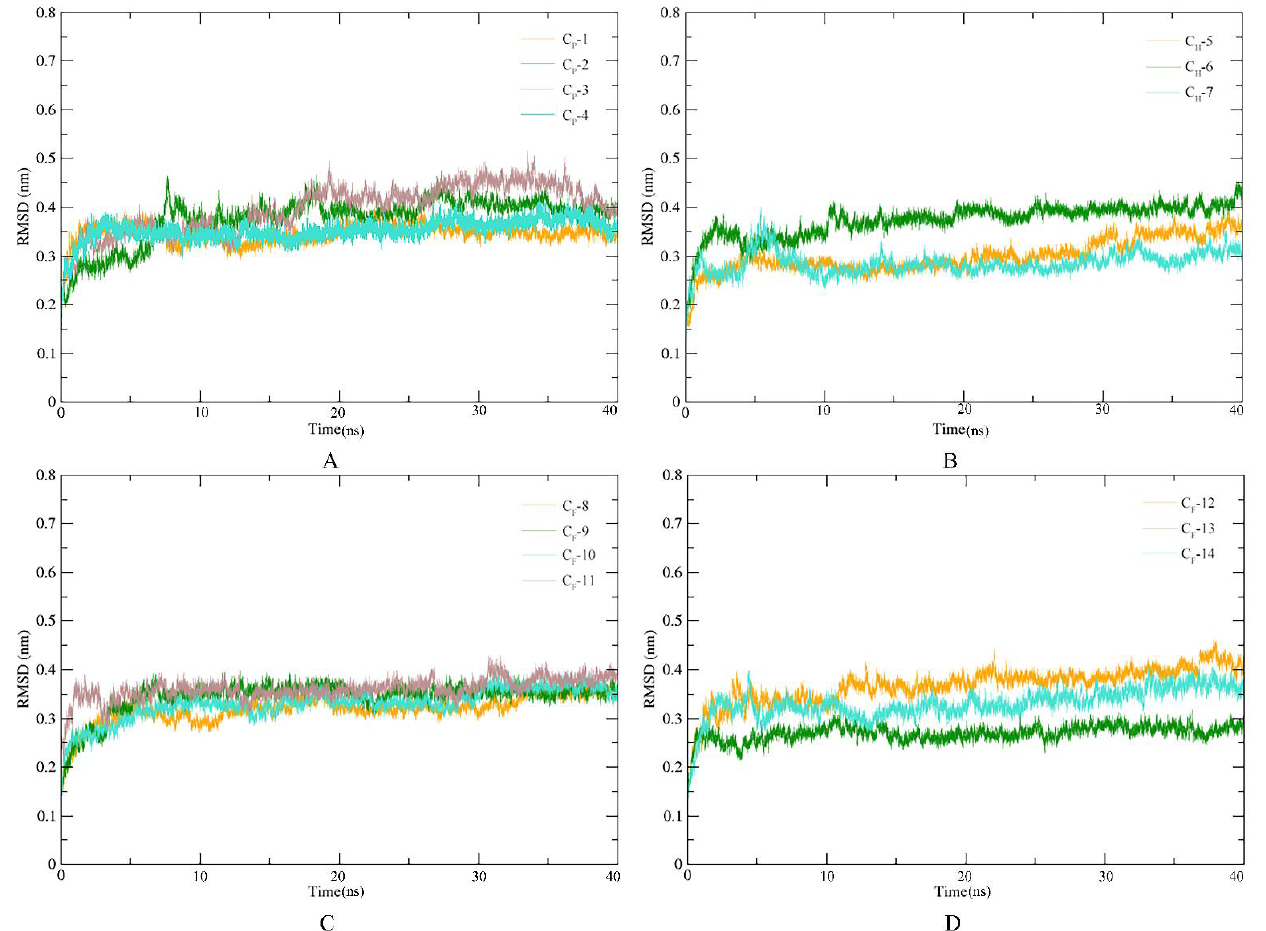
Figure 8. The root-mean-square deviation (RMSD) value for carbon backbones of SnitCSP4-ligand complexes during the 40 ns molecular dynamics (MD) simulations. (A) RMSD of C P -1 , C P -2 , C P- 3 , complexes during the 40 ns molecular dynamics (MD) simulations. ( A ) RMSD of C P -1 , C P -2 , C P- 3 , C P -4; (B) RMSD of C H -5 , C H -6 , C H -7; (C) RMSD of C F -8 , C F -9 , C F- 10 , C F -11; (D) RMSD of C F -12 , C F -13 , C P -4; ( B ) RMSD of C H -5 , C H -6 , C H -7; ( C ) RMSD of C F -8 , C F -9 , C F- 10 , C F -11; ( D ) RMSD of C F -12 , C F- 14 . C F -13 , C F-